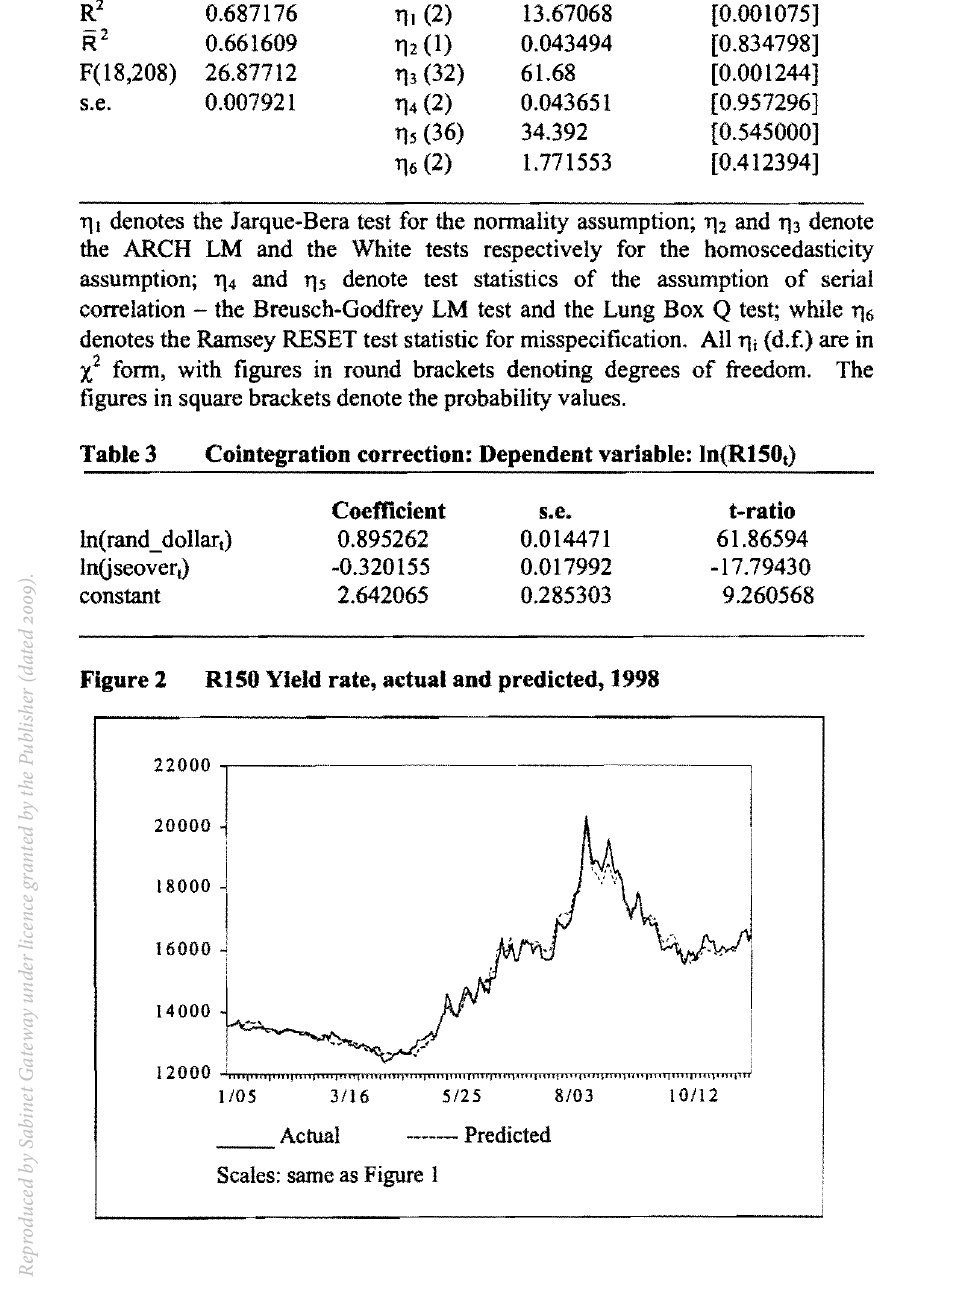
Scales: same as Figure